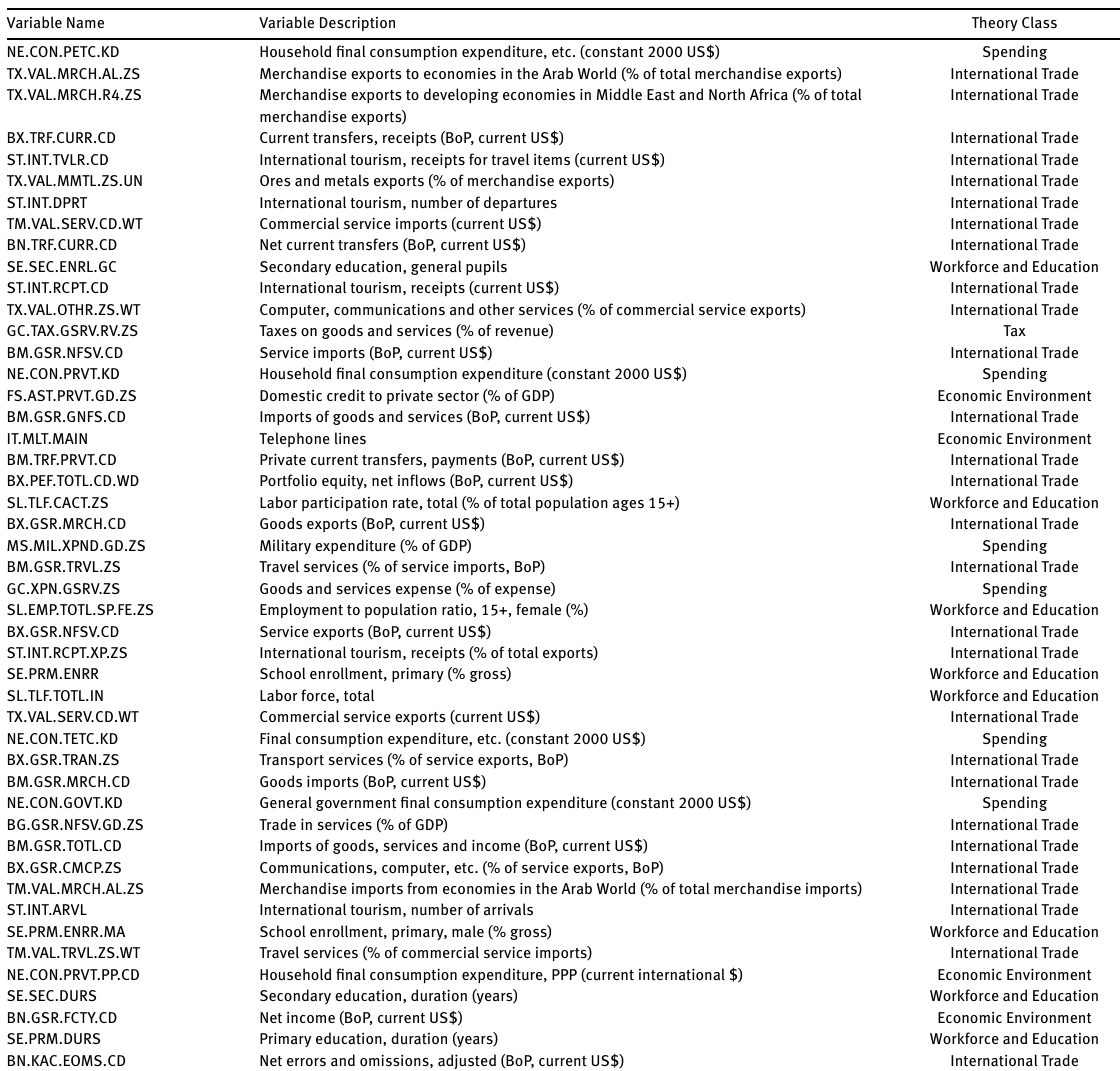
Table 12: List of Applied Risk Indicators